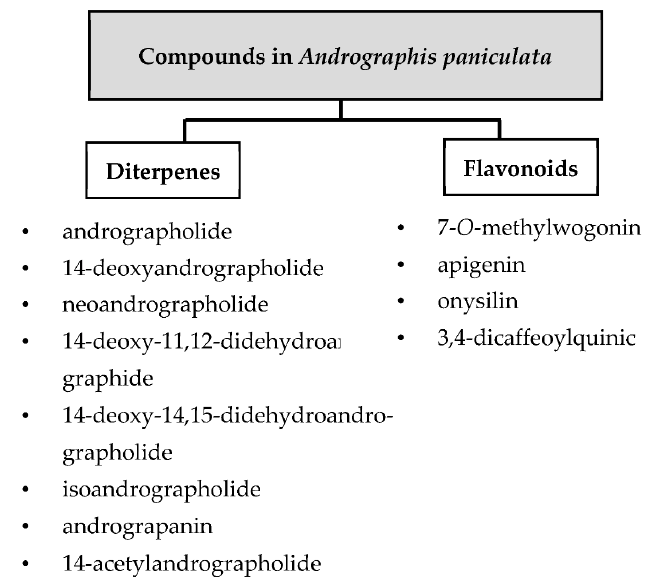
Figure 2. List of compounds isolated from A. paniculata [13,15–19].